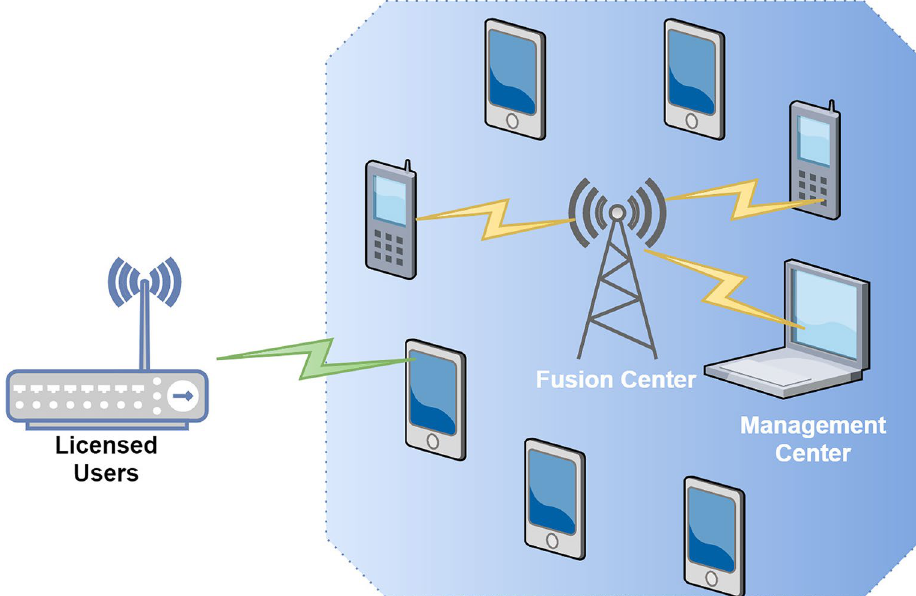
Figure 2. Blockchain-enabled cognitive wireless network.